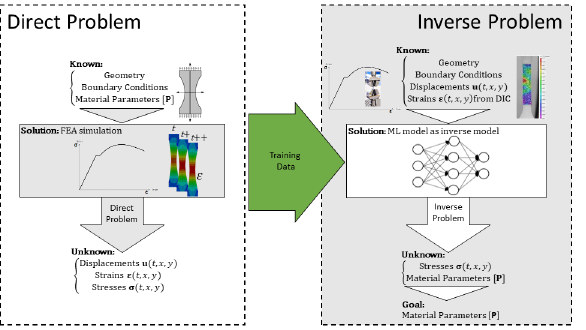
Figure 1. ML as an inverse model for parameter identification. The training data is obtained using the direct problem FEA results.